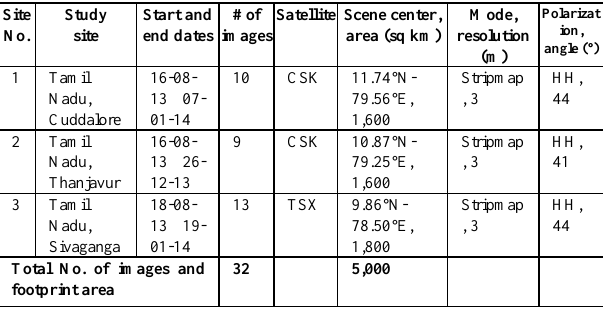
Table 1. SAR data acquisition summary: locations, dates and modes used for 2013 Samba